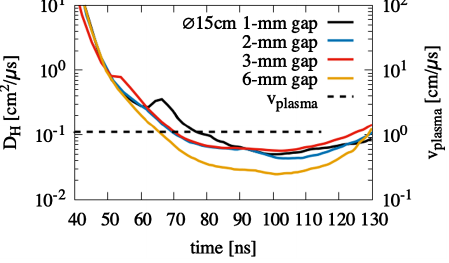
FIG. 9. D H from Eq. (11) estimated for the Fig. 8 geometries. Using D H ∇ n ¼ n v , with n ∼ 10 16 cm − 3 and ∇ n ∼ 10 17 cm − 4 from simulation, D H provides an estimated v that is consistent with the simulated average plasma expansion velocity shown on the right